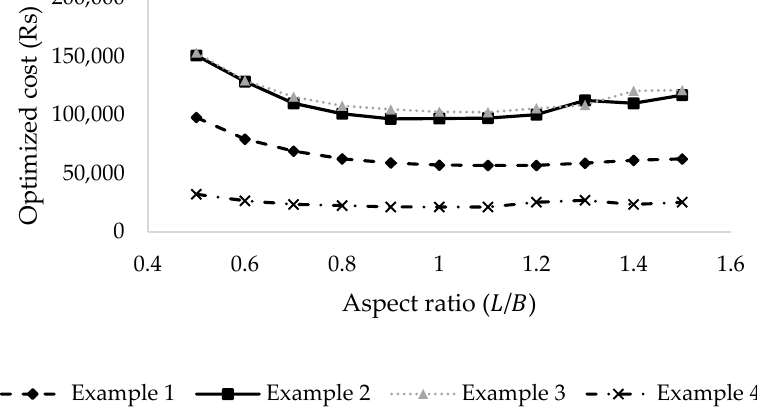
Figure 11. Effect of aspect ratio on cost.